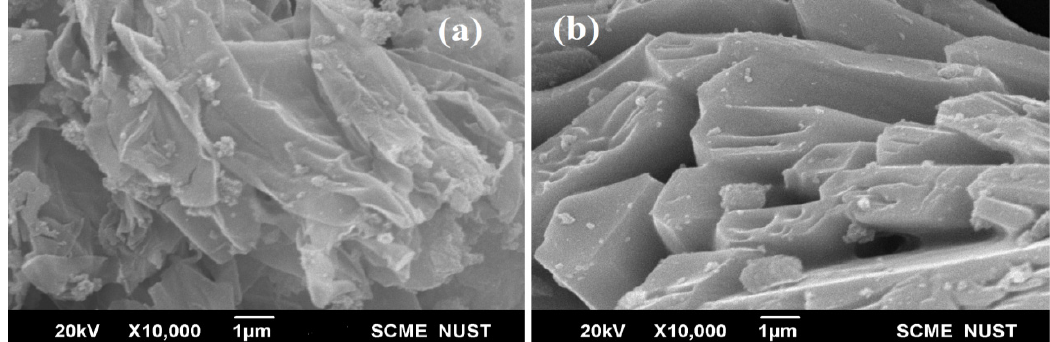
Figure 2. Scanning electron microscopy of prepared activated carbon ( a ) Lantana Camara ( b ). Lan- tana Camara